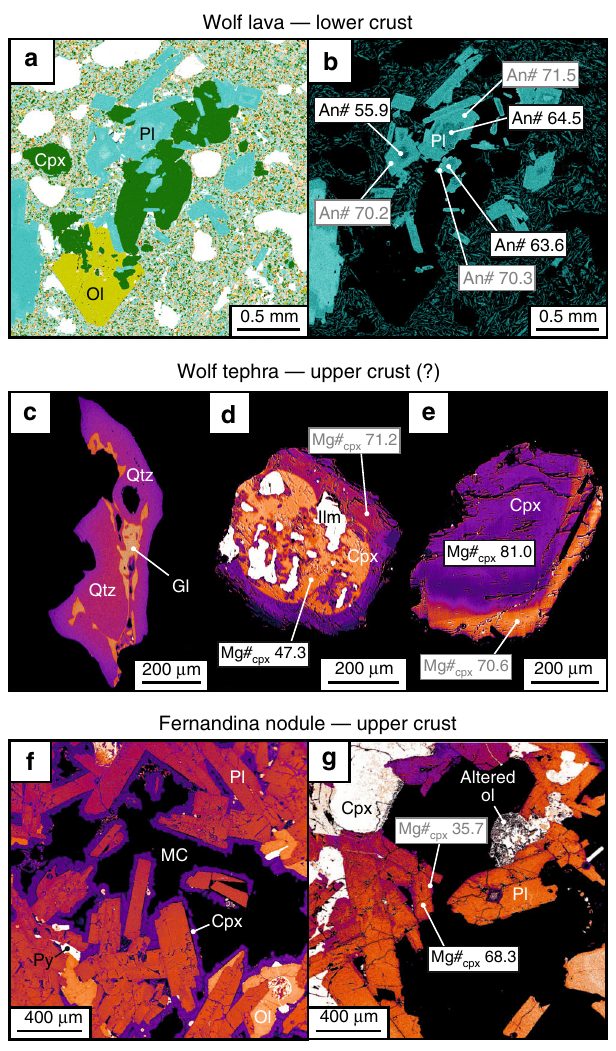
Fig. 3 Petrographic evidence for heterogeneous liquids and multi-level magma storage. a Quantitative Evaluation of Minerals by SCANing electron microscopy (QEMSCAN) phase map and b Ca map of a glomerocryst in a 2015 Wolf lava sample. The values in ( b ) show the An# of plagioclase zones. c − e False colour backscattered electron (BSE) images of quartz and clinopyroxene crystals in tephra samples from the 2015 Wolf eruption ( d and e are adapted from Stock et al. 19 ). The values in ( d ) and ( e ) show the Mg# cpx of clinopyroxene zones. f , g False colour BSE images of nodule samples from the 1968 Fernandina eruption, showing the phaneritic texture, a miarolitic cavity and evidence of hydrothermal alteration. An# and Mg# cpx values in black and grey show averages from crystal cores and rims, respectively. Ol – olivine, Cpx – clinopyroxene, Pl – plagioclase, Qtz – quartz, Gl – glass, Ilm – ilmenite, Py – pyrite, MC – miarolitic